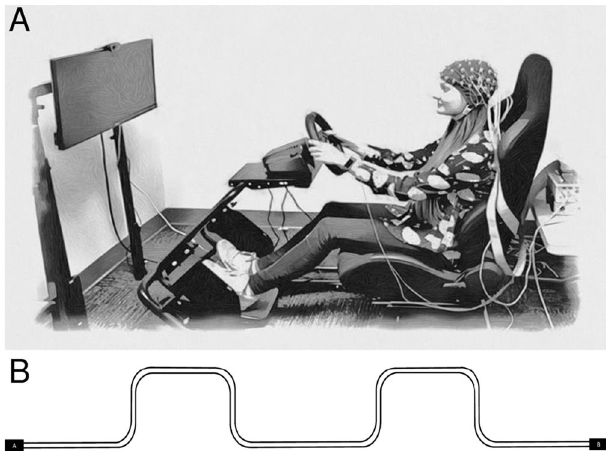
Figure 1. Experimental set-up on a pseudoparticipant ( A ), and the driving course ( B ). The start and end of the driving course was counterbalanced to ensure the direction of the first